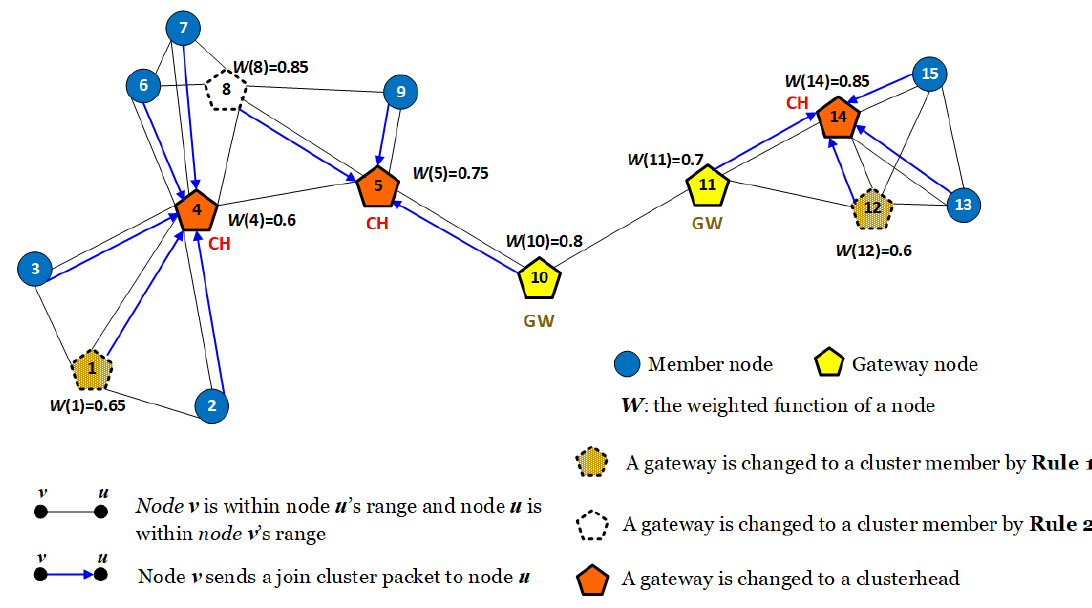
Figure 5. The basic concept of the proposed CDS based clustering